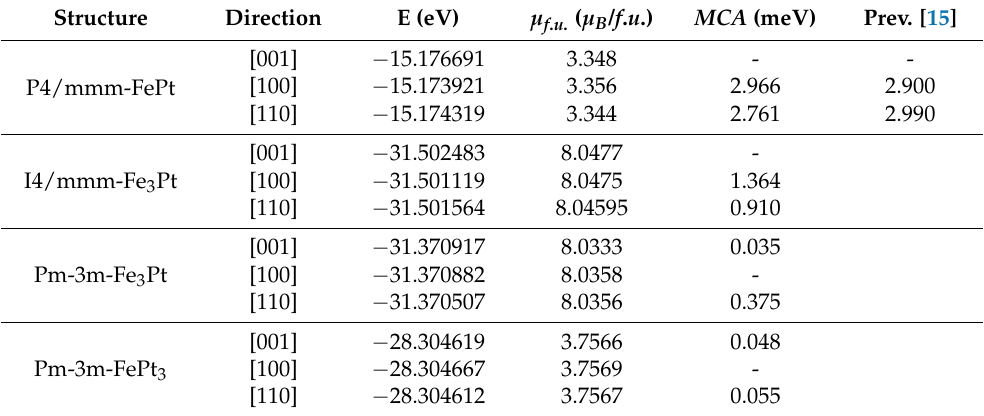
Table 3. Relative energies and MCAs along the [001], [100], and [110] directions. Structure Direction E (eV) µ f . u . ( µ B / f . u .) MCA (meV) Prev. [15] P4/mmm-FePt